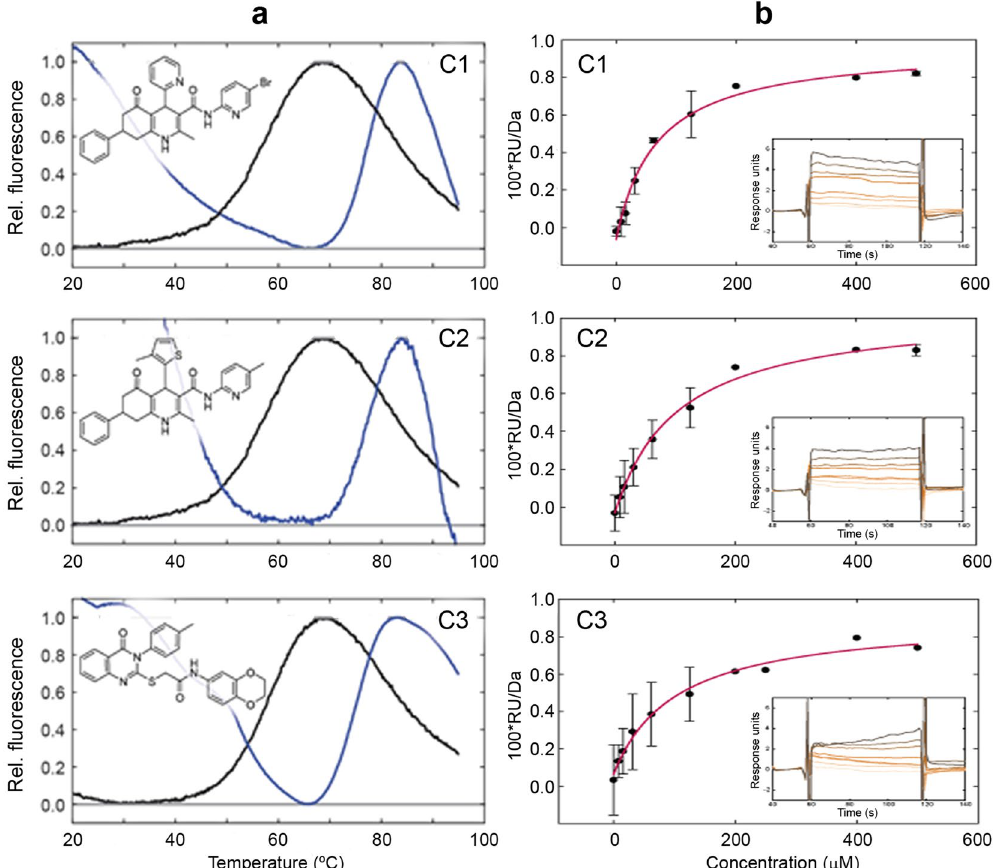
Figure 2. Hit compounds C1, C2 and C3 bind NPM, stabilizing the C-terminal domain. DSF profiles of NPM C-terminal domain in the absence (black line) and presence (blue line) of hit compounds C1, C2 and C3, and chemical formulae of the compounds ( a ). Isotherms for compound hits (C1, C2 and C3) binding to NPM analyzed by surface plasmon resonance ( b ). Experiments were performed in triplicate with each inset depicting a representative original sensorgram at compound concentrations 0, 7.81, 15.6, 31.2, 62.5, 125, 250 and 500 µ M (corresponding increase in color intensity), all in 5% DMSO. S 0.5 values of 68 ± 13 µ M for C1, 105 ± 17 µ M for C2 and 102 ± 23 µ M for C3 were obtained from fittings to a 1:1 binding